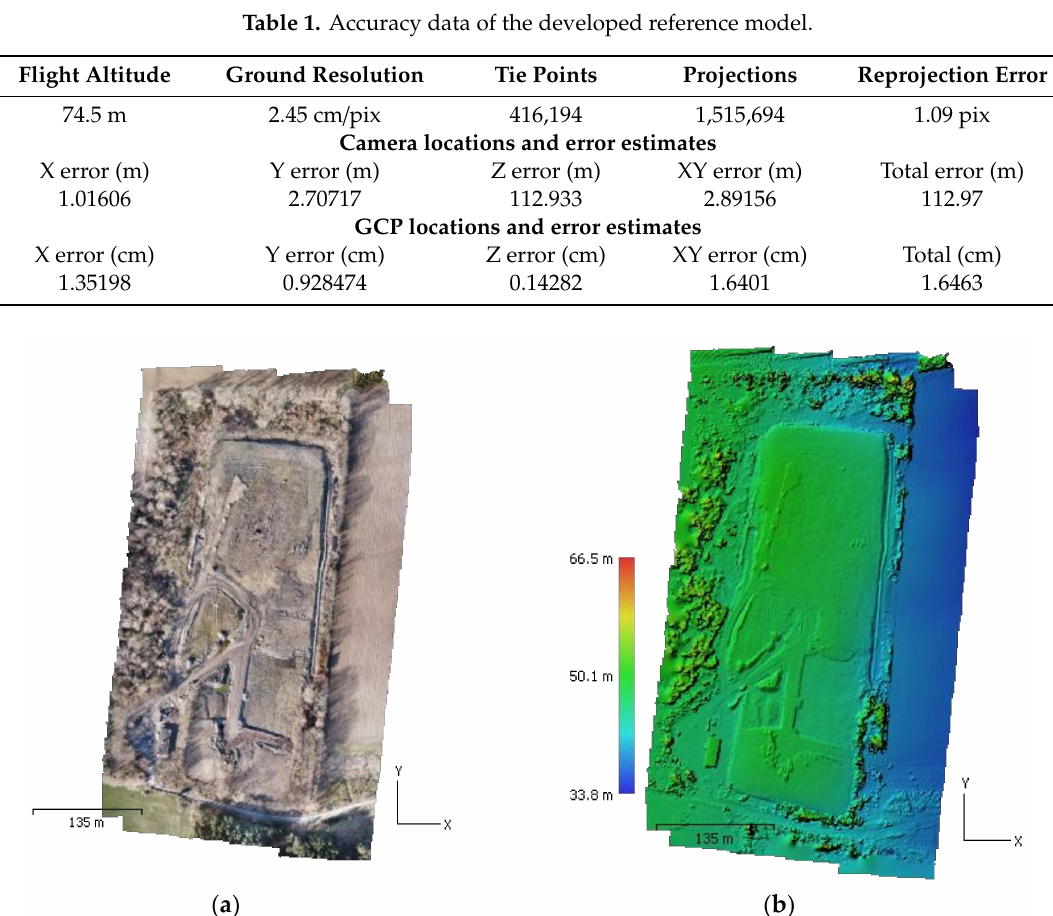
Figure 3. Reference model: ( a ) orthoimage; ( b ) digital surface model